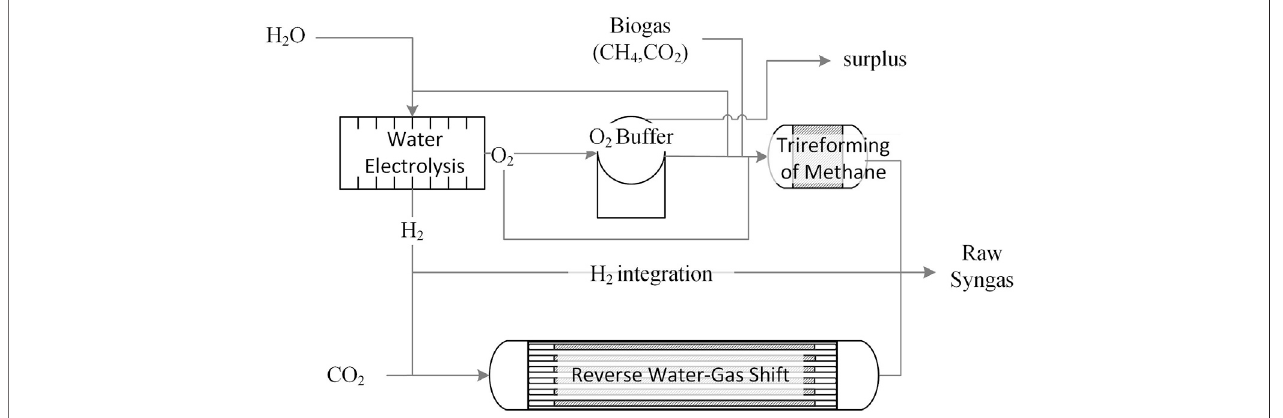
FIGURE1| OverallPlantlayout:theRWGSandTRIreactorsproducerawsyngas,whereH 2 andO 2 aresupplied via EL.H 2 maybefedtoRWGSand/orbypassthe reactor to the syngas product stream whereas excess O 2 may be stored in a buffering device. CO 2 could be obtained from biogas using a suitable separation strategy.